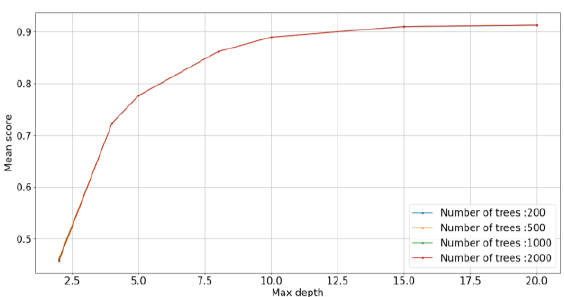
Figure 2 . Mean performance with RF for different parameters (sample size = 20%; training: entire area).